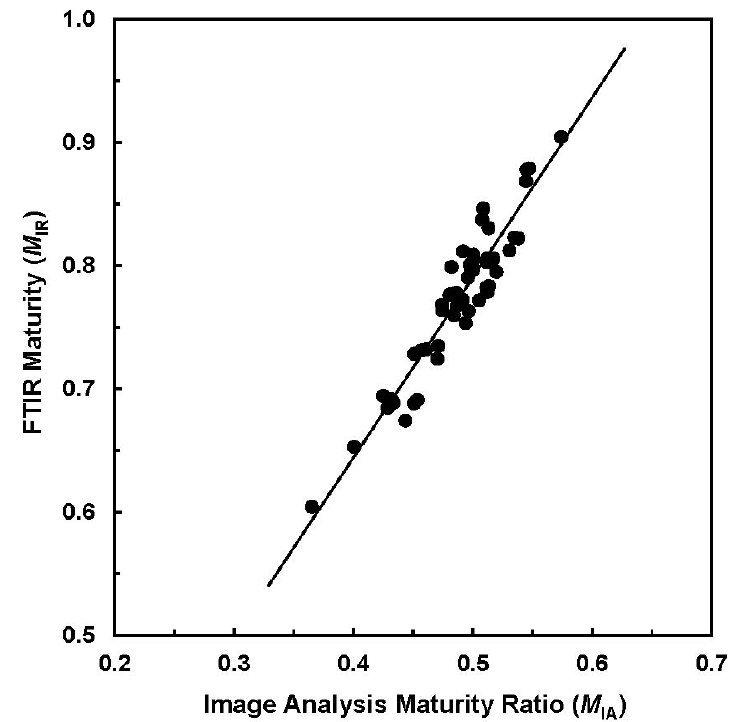
Figure 3. Relationship of M from image analysis (IA) procedure vs. M IA total reflection (ATR) sampling device based Fourier transform infrared (ATR-FTIR) measurement (R 2 = 0.894) (Reprinted with permission from [16]. Copyright 2011